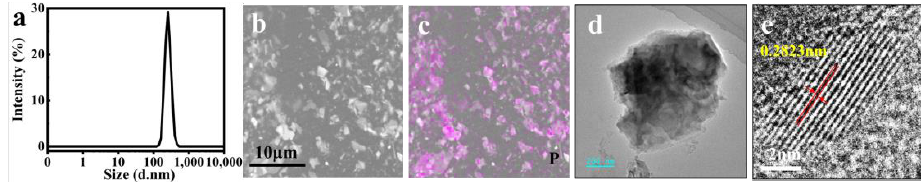
Figure 1. Morphologies of BP@SF nanosheets. ( a ) Particle size distribution (PDI = 0.688); ( b ) SEM. Scale bar of 10 nm; ( c ) EDS. Phosphorus distribution, scale bar of 10 nm; ( d ) TEM. Scale bar of 200 nm; ( e ) selected area electron diffraction. Scale bar of 2 nm.